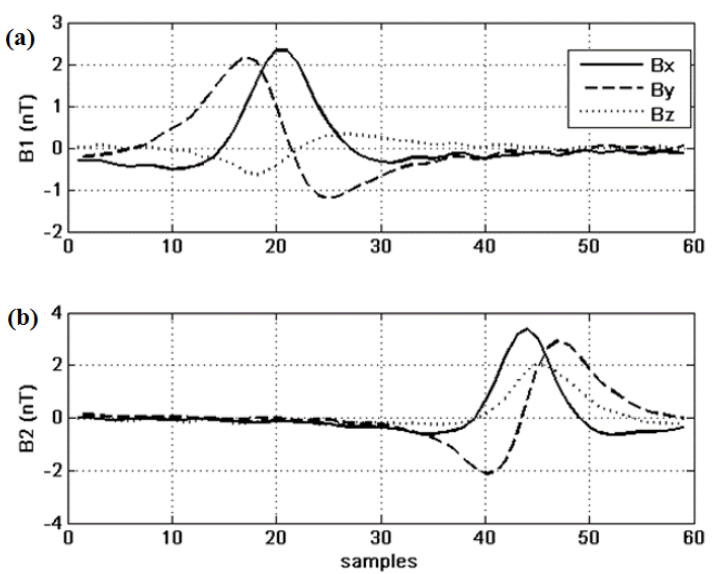
Figure 3. Pre-processed data from the two sensors S1 ( a ) and S2 ( b ) after filttration, detrending and decimation.